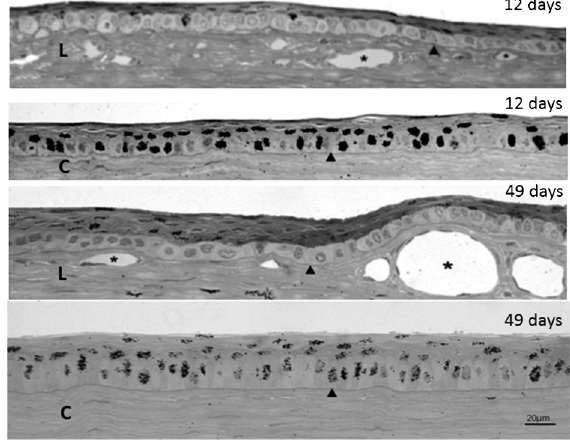
Figure 3. Autoradiography of semithin sections of rabbit eyes injected three times with [ 3 H]-TdR and killed at 12 and 49 days after the first injection, showing both the limbus (L) and the center of the cornea (C). The cuboid clear cells making up the basal stratum in the limbus are conspicuous. Arrowheads indicate the basal membranes; asterisks are in the lumen of blood vessels.